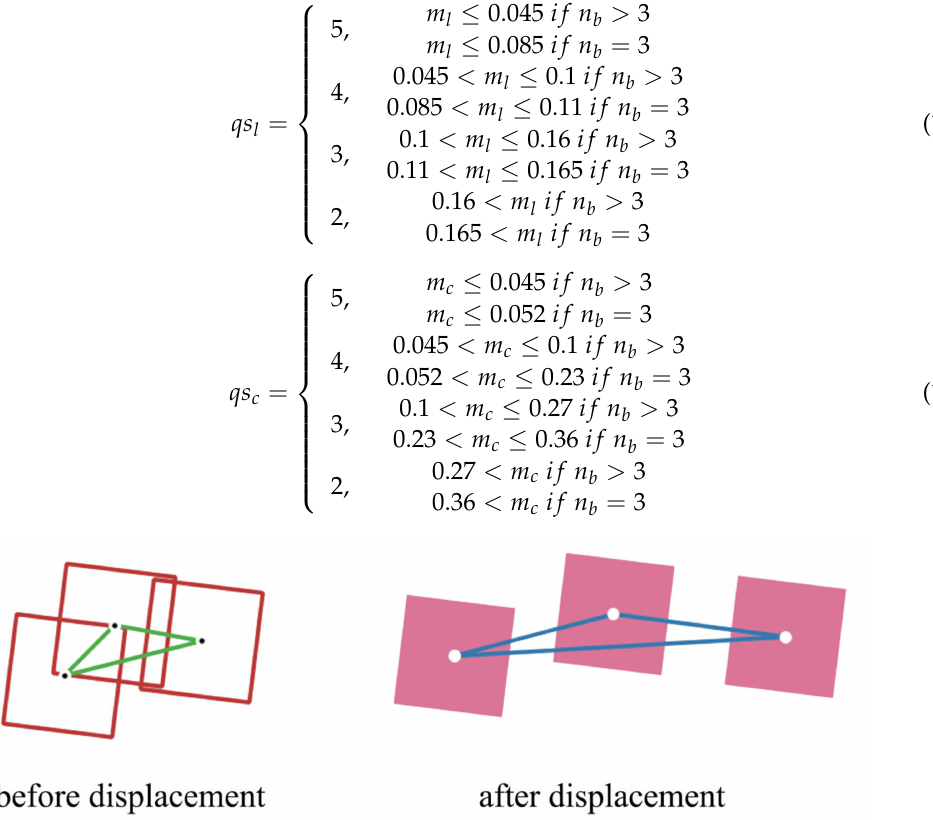
Figure 13. An example of a group with three buildings and their triangles before and after displacement. Finally, the quality score ( QS ) is calculated by averaging the scores of those measures derived based on the above criteria (Equation (16)). For the measures, equal weights were used since their individual performances according to the visual assessment were similar. Accordingly, the quality rank ( QR ) is assigned to the zones as explained above.